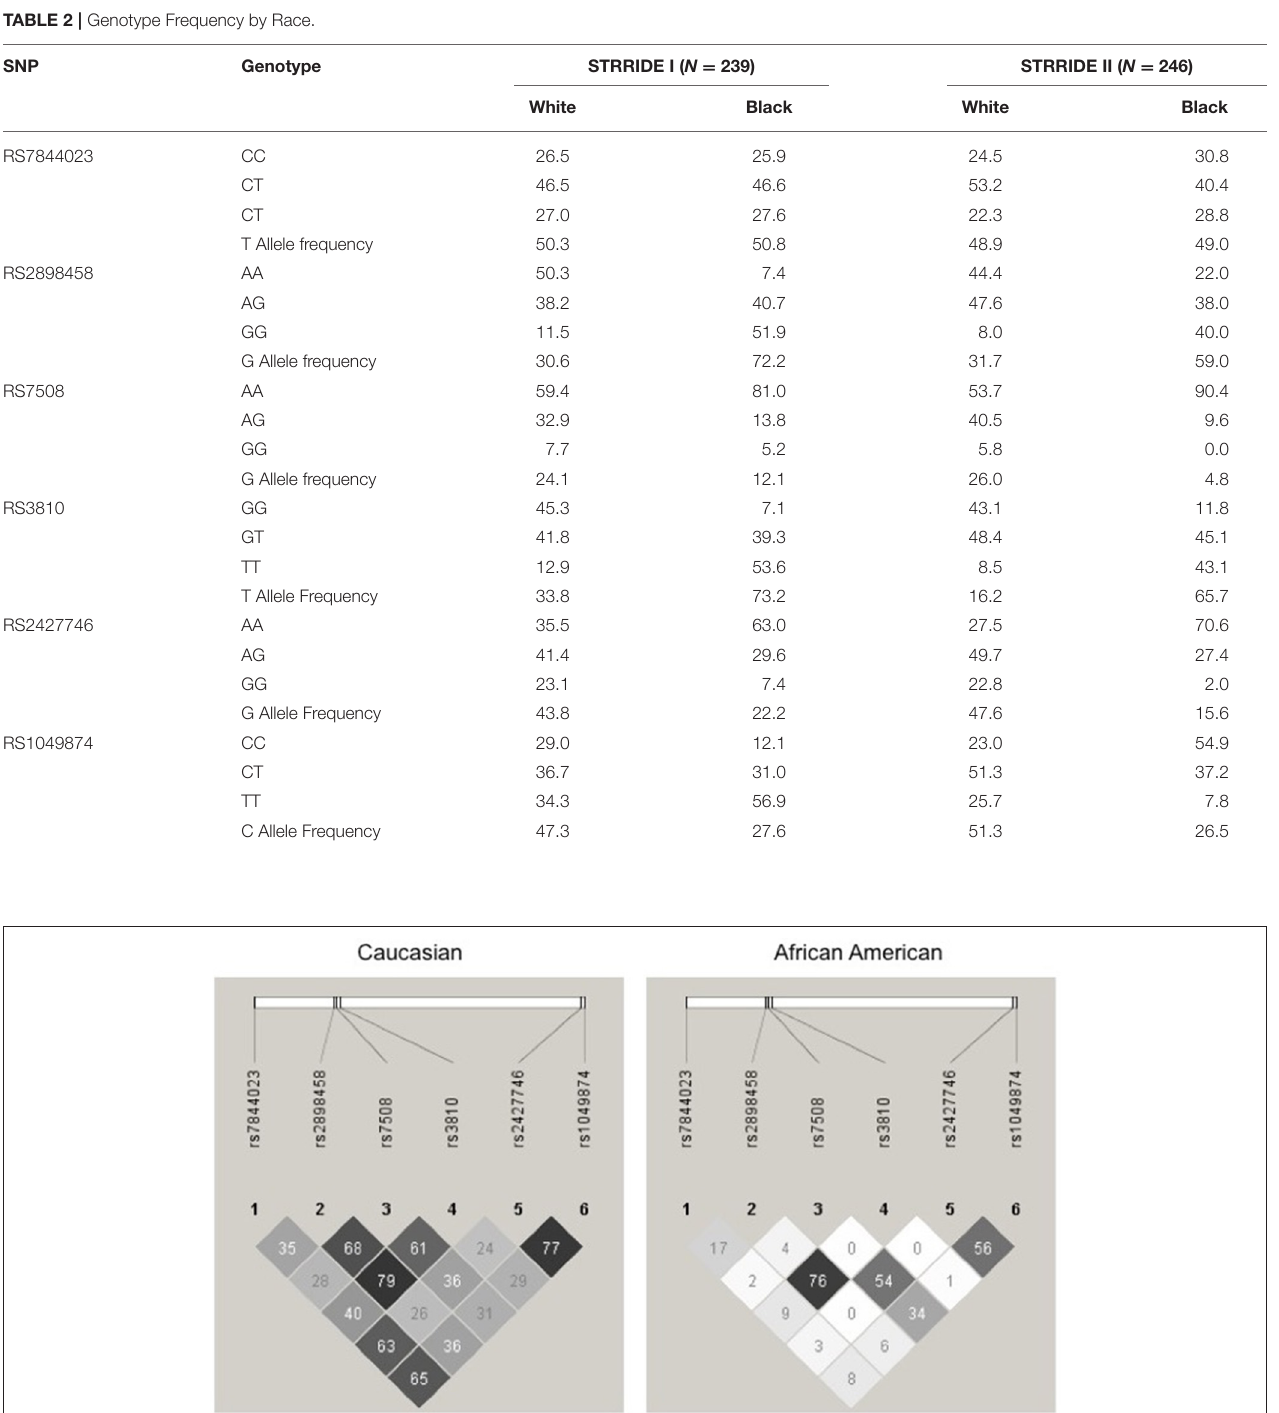
Frontiers in Physiology |